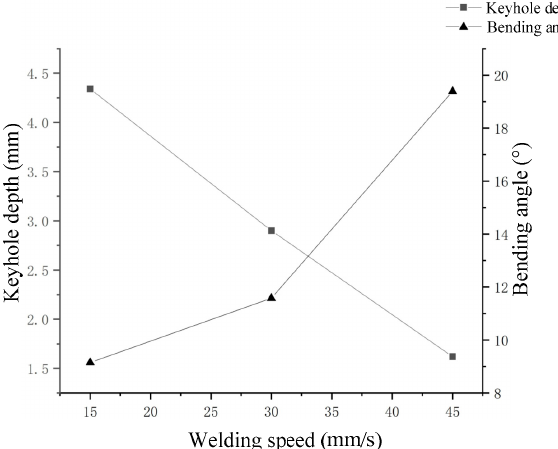
Figure 14. Effect of welding speed on keyhole depth and bending angle.